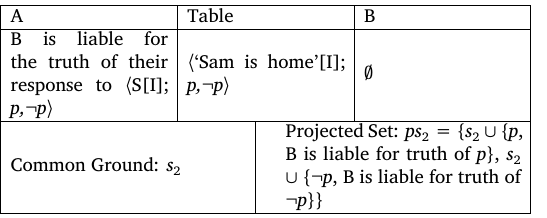
: A asks “Is Sam Table 2 K 2 home?” relative to the